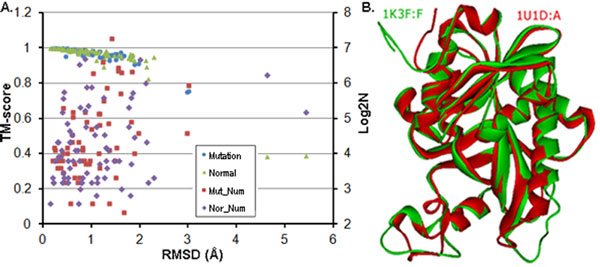
Protein structural flexibility. (A) The maximum RMSD and equivalent minimum TM-score of the structural groups. The red rectangles and purple diamonds represent the base 2 logs of the structural numbers in structural groups with (blue dots) or without mutations (green triangles), respectively. (B) Structural comparison of PDB: 1U1D: A (red) [31] and PDB: 1K3F: F (green) [32].